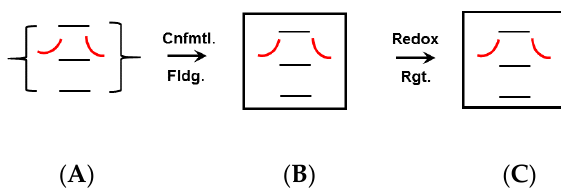
Scheme 5. The conformational folding of a formation of an unstructured native disulfide bond- containing intermediate ( A ) to form a structured-intermediate with buried cysteines ( B ). The latter tends to be kinetically trapped as structure occludes the buried cysteines from becoming disulfides. The presence of redox reagents has no impact on the species ( C